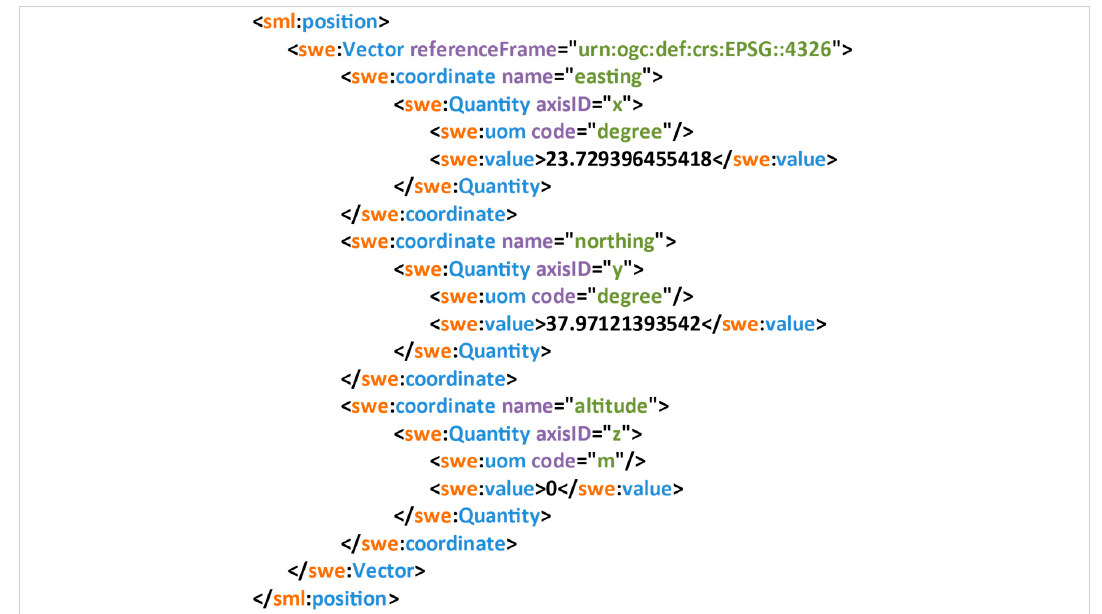
Figure 10. Insert sensor XML request, position property(SOS-SensorML2.0).